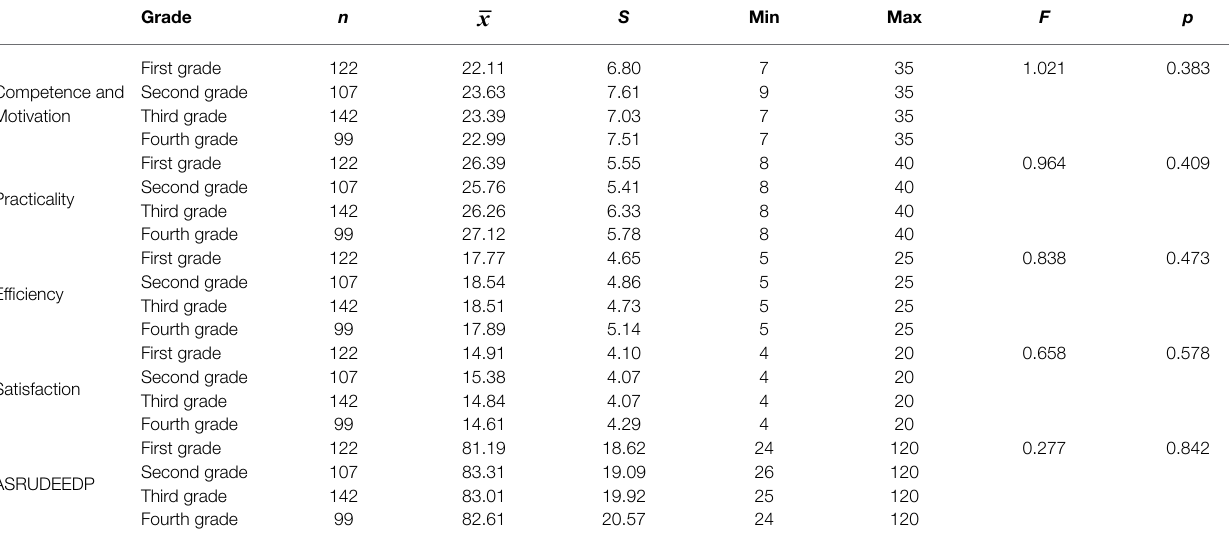
TABLE 3 | Comparison of the students’ scores from ASRUDEEDP according to their grades.